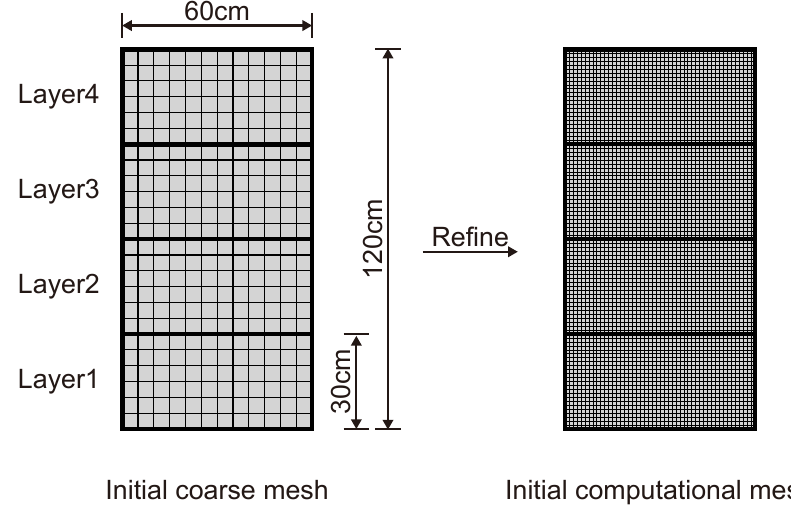
Figure 5. The FEM mesh of Example